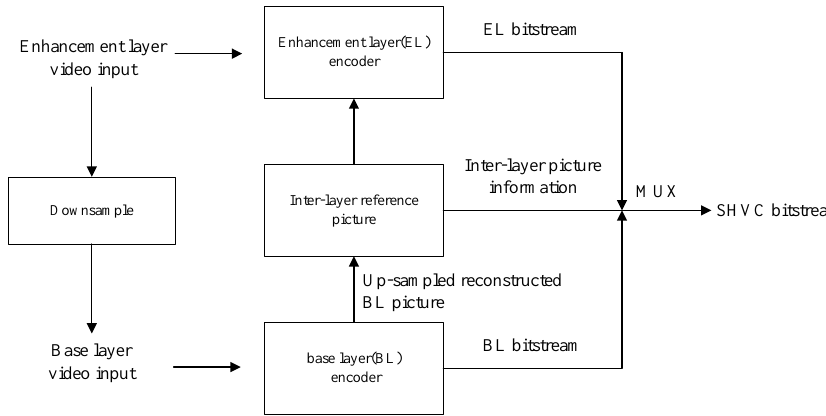
Figure 3. Conceptual diagram of H.265 scalable high efficiency video coding (SHVC). EL, enhancement layer; BL, base layer; MUX, multiplexer.